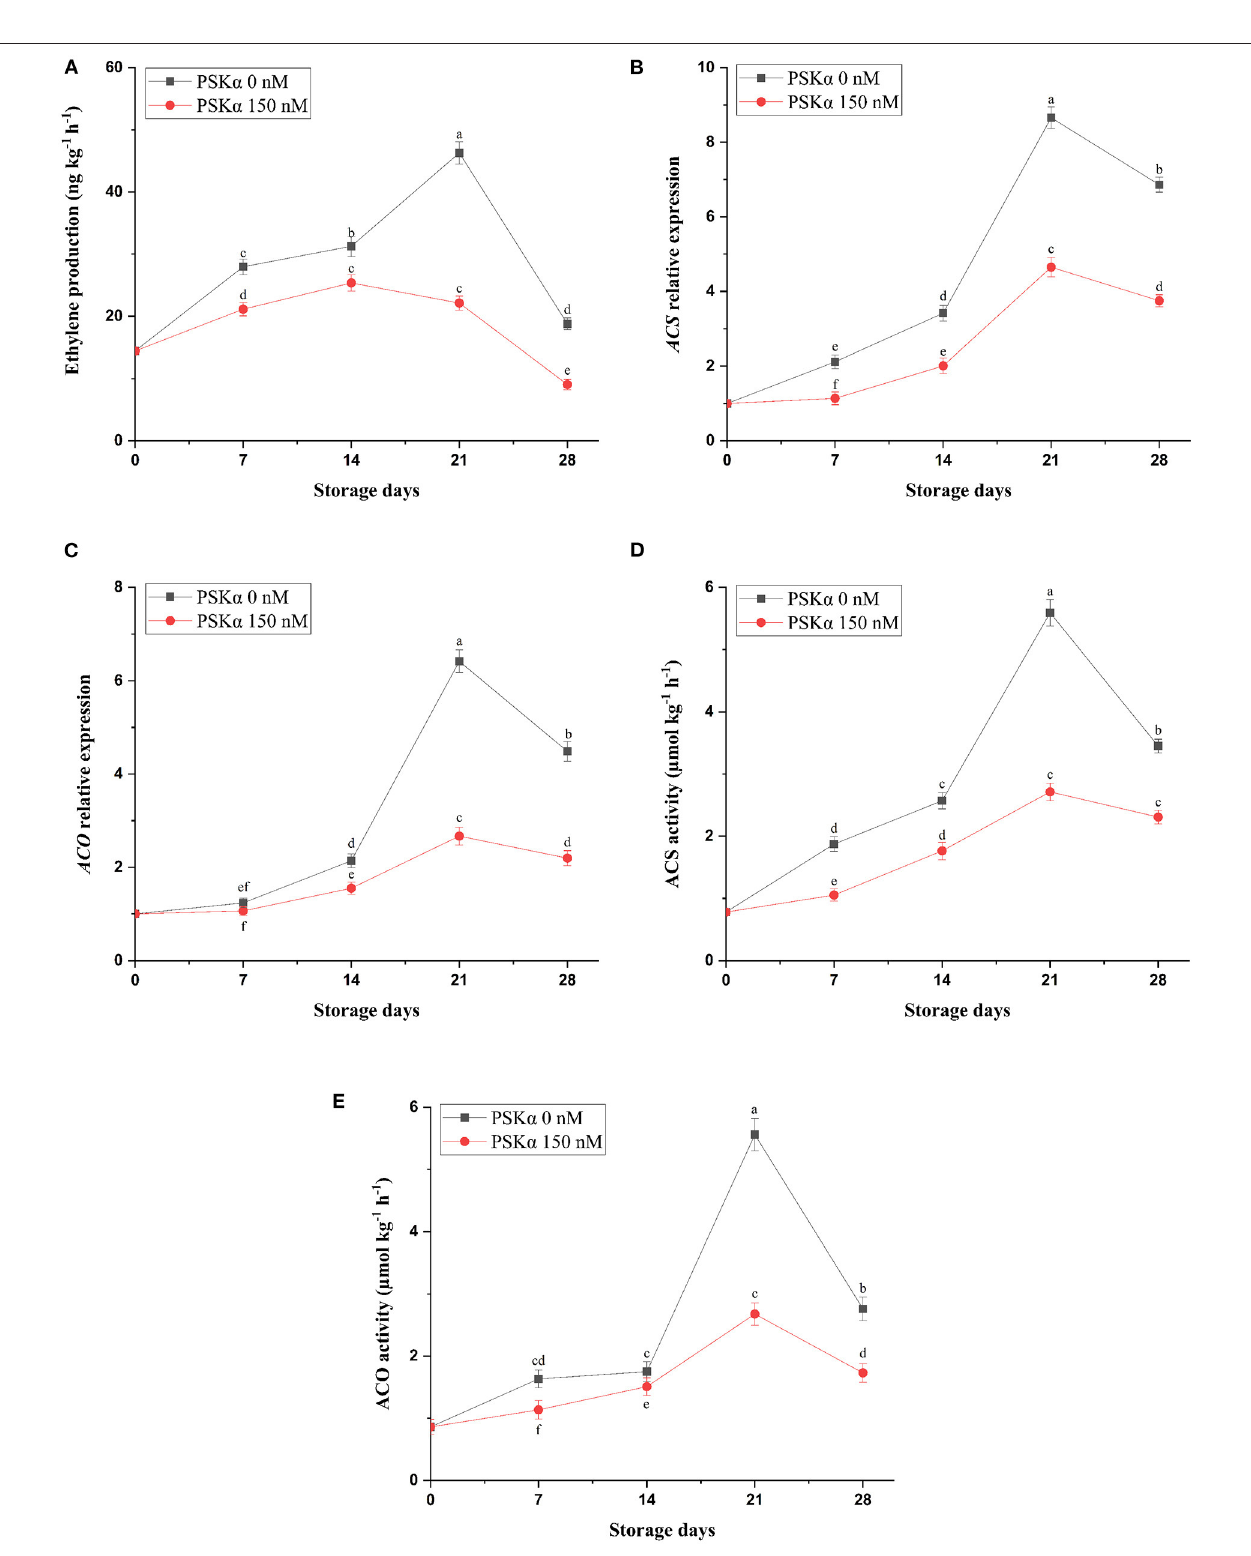
FIGURE 1 | Ethylene production (A) accompanied by ACS and ACO gene expressions (B,C) and enzyme activities (D,E) in broccoli floret treated with PSK α at 0 and 150nM during storage at 4 ◦ C for 28 days. Data shown are mean values of n = 3, and the error bars represent standard errors of the means. Tukey’s test at P = 0.05